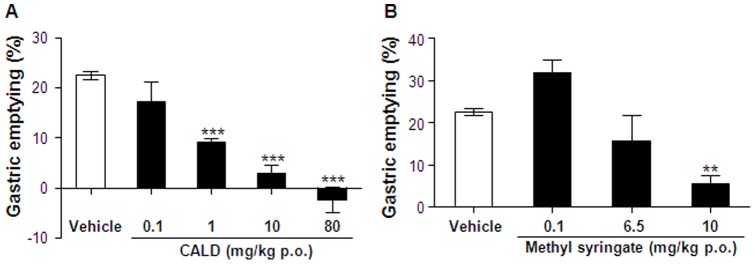
Effects of cinnamaldehyde (CALD) and methyl syringate (MS) on gastric emptying.Phenol red was administered 5 min after treatment with vehicle (1.5% methyl cellulose), CALD (0.1–80 mg/kg) and MS (0.1–10 mg/kg). Gastric emptying was evaluated by measuring the quantity of phenol red retained in the stomach 15 min after administration. Columns and vertical bars represent means ± SEM (n = 4); *p<0.05 compared with the vehicle control.